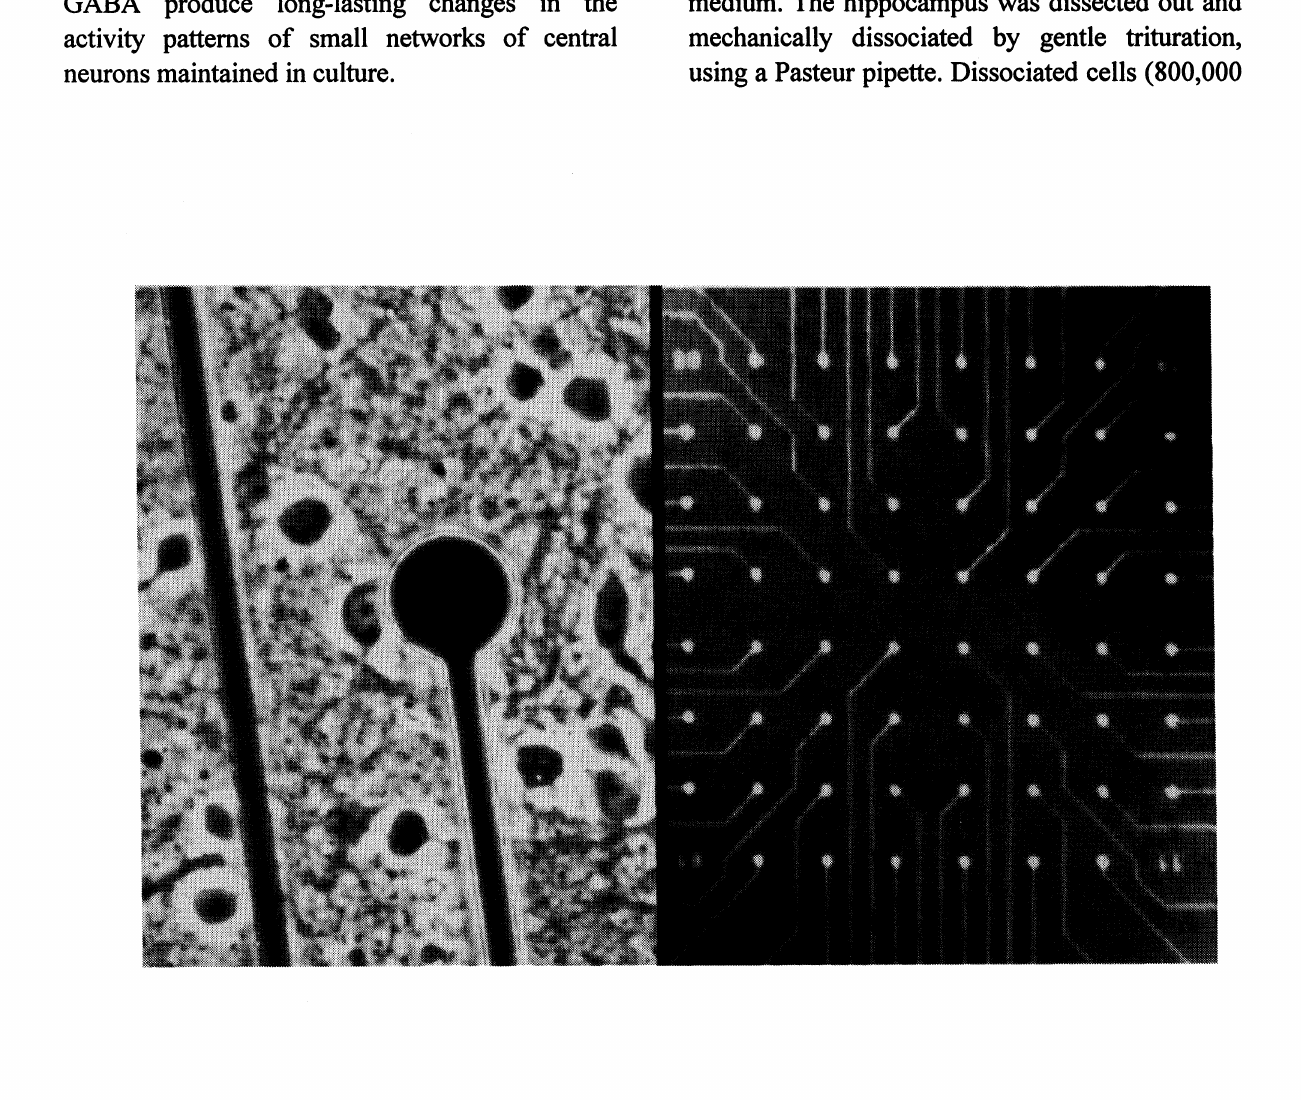
Fig. 1: The multi electrode recording system. Left, a low power view of the arrangement of the multielectrode surface. The distance between the electrode tips is 200 tm, and the size of each electrode tip is 20 tm. Right, a higher power view of a cell growing on an electrode tip, partially hidden by the electrode. The density of cell plating is such that an electrode is not likely to detect activity of more than one cell, although occasionally the activity of two cells is recorded simultaneously from an electrode. In such cases, the separation between them is quite clear (see